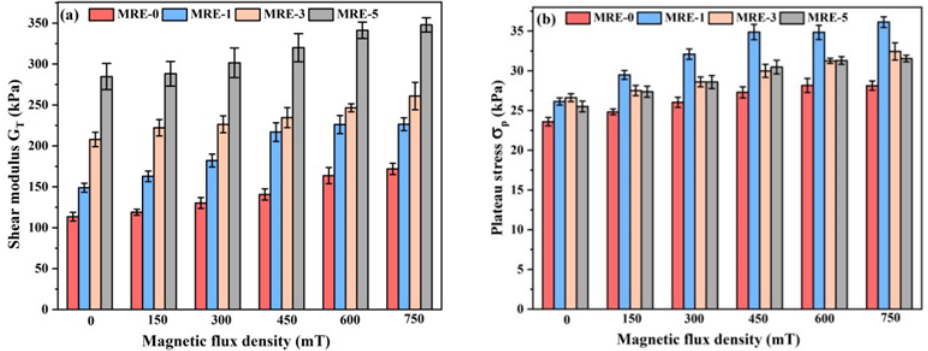
Figure 6. ( a ) Steady-state shear modulus; and ( b ) plateau stress of the MREs under various magnetic fields.